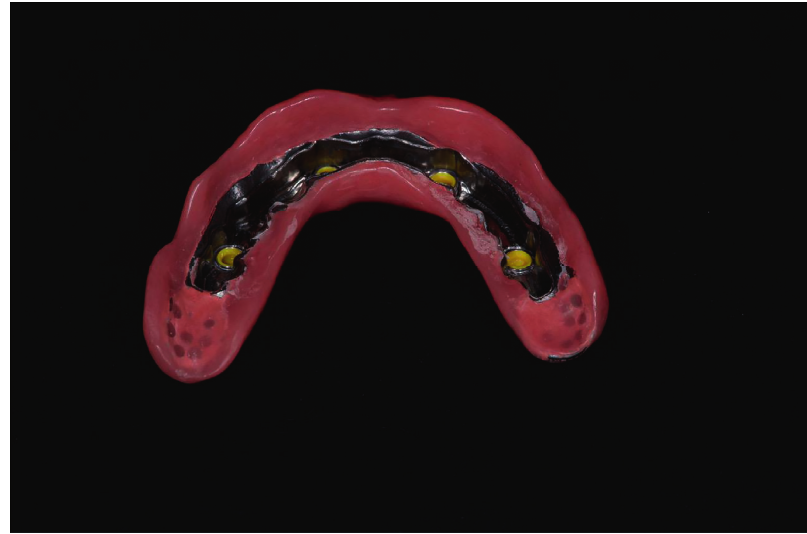
Figure 3: View of the internal surface of the